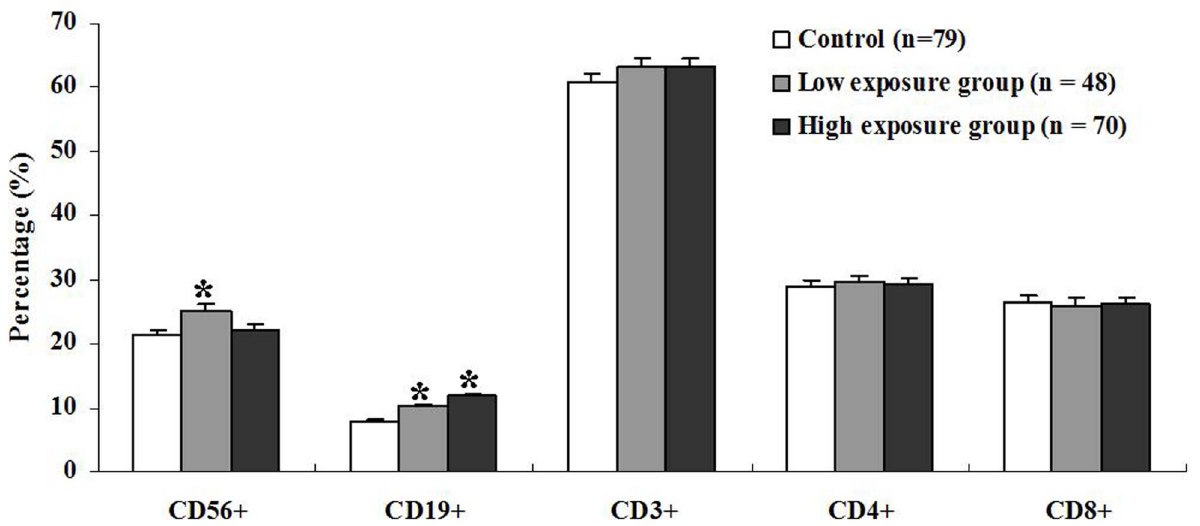
Figure 2. The distribution of major lymphocyte subsets in FA-exposed workers (n=48 in the low exposure group and n=70 in the high exposure group) and the control (n=79). Percentage of different lymphocytes was presented in the three groups. Aliquots of EDTA whole blood were stained with fluorescence labeled antibodies to the CD3 + , CD4 + , CD8 + , CD19 + and/or CD56 + lymphocytes. Values represent mean 6 SE; * p , 0.05 comparing with control.